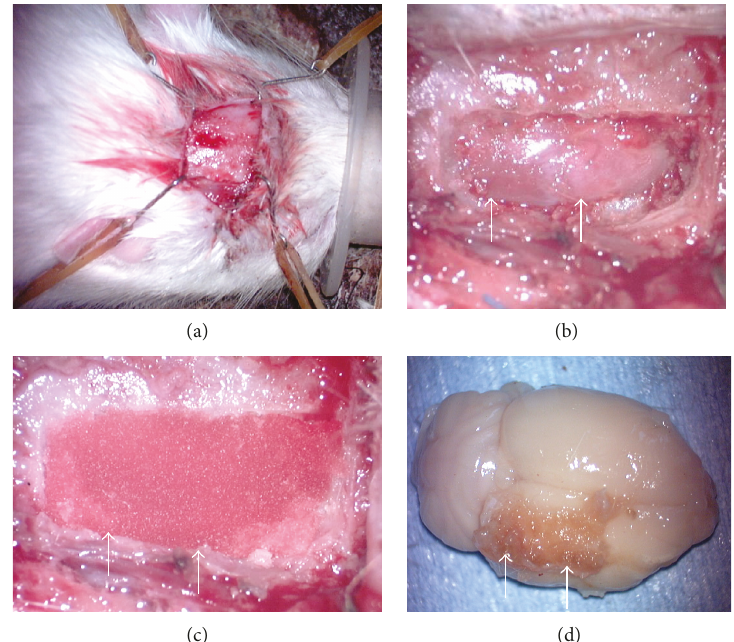
Figure 2: Cell transplantation in the BMSC/sca ff old group. Panels (a), (b), and (c) show photographs of the surgical treatment for cell transplantation in the BMSC/sca ff old group. Panel (d) shows a brain removed 35 days posttransplantation in the BMSC/sca ff old group. Arrows indicate the outer rim of the craniotomy (b), the RCP sponge with BMSCs (c), and remaining sponge